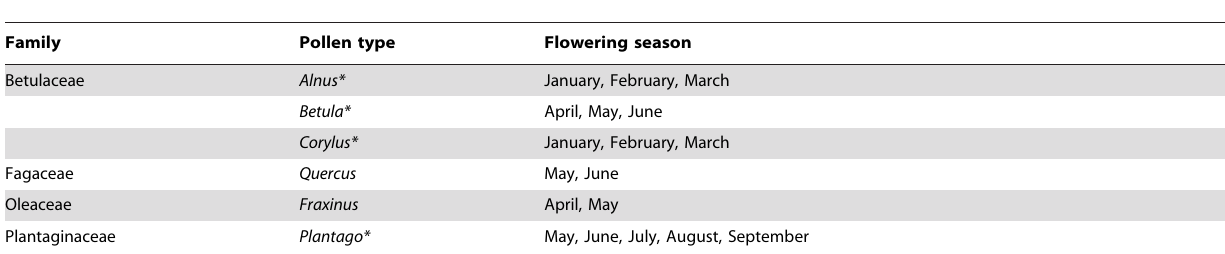
Table 2. Selected pollen types of tree and herb species and their flowering season.